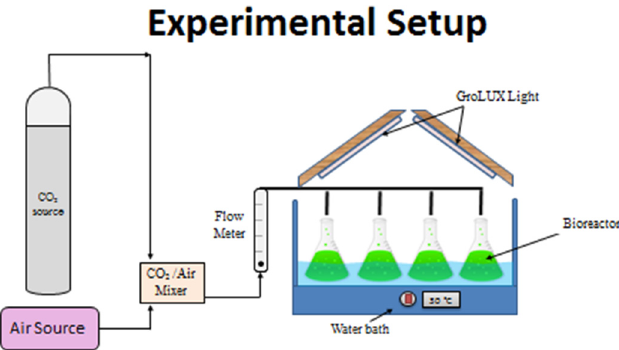
Fig. 1. Schematic diagram of the experimental setup used to